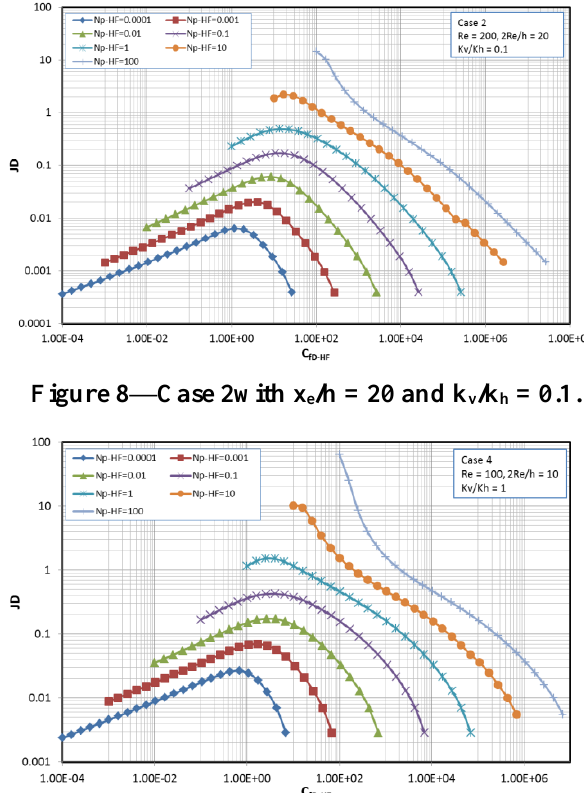
/k = 0.1. Figure 10—Case 4 with x v h